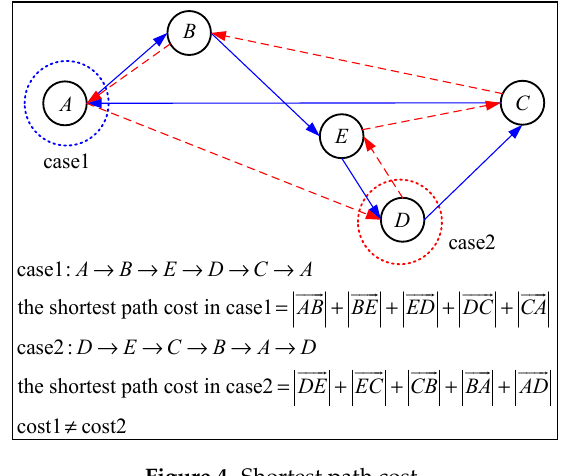
Figure 4. Shortest path cost.